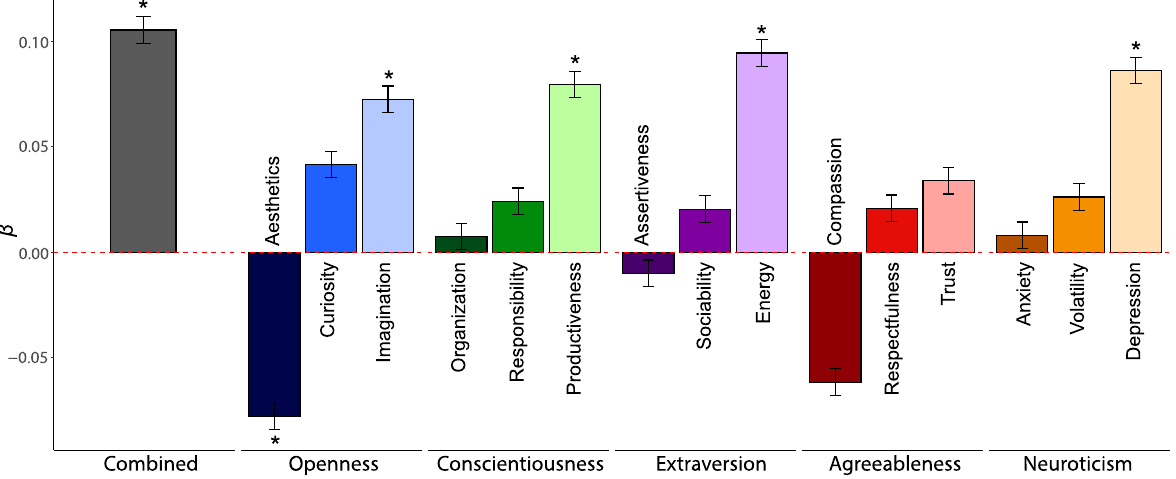
Figure 3. The relationship between personality similarity and neural synchrony. Standardized regression coefficients for the overall personality similarity measure as well as for the 15 individual personality facets. The color coding highlights the five main traits, with different shades of the same color distinguishing between the facets (e.g., dark to light blue for the three Openness facets). All coefficients are sorted by effect size within each Big Five trait. Asterisks indicate permutation-tested significance levels with * p <